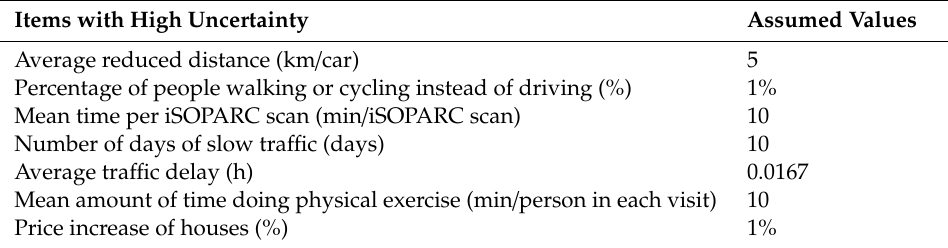
Table 2. Items with highest uncertainty in the CBA of Thinking